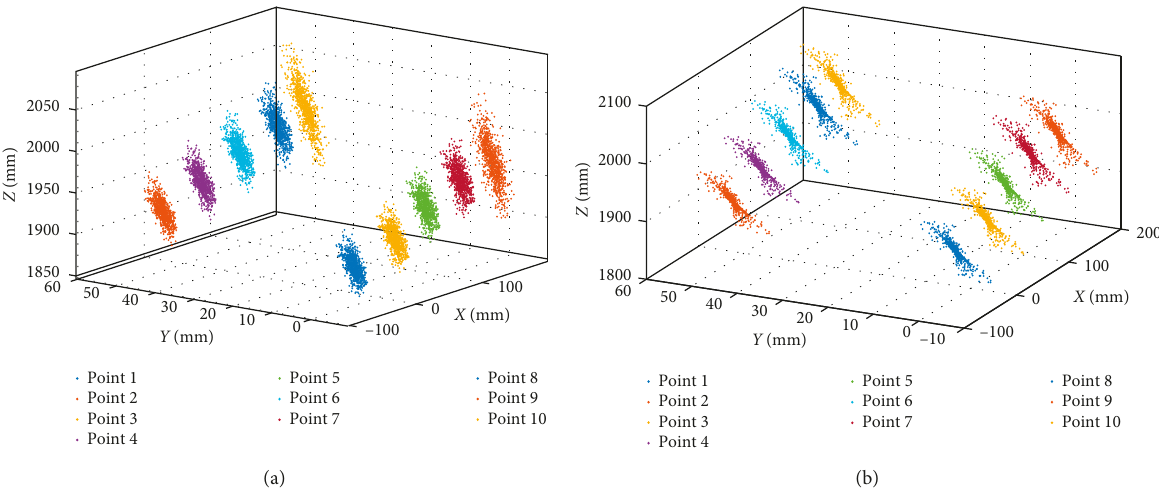
Figure 8: 3D space motion trajectories: (a) random excitation and (b) impact